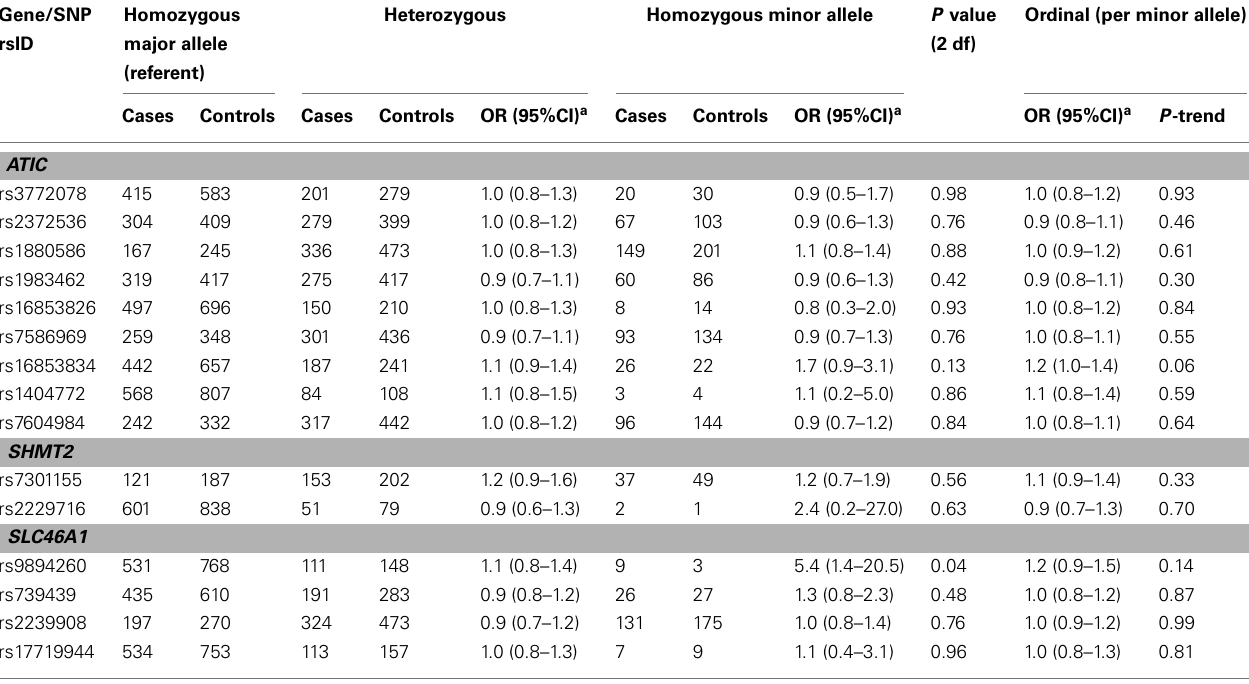
TableA4 | Odds ratios (OR) and 95% CIs for the main effect association between variants in ATIC , SHMT2 , and SLC46A1 and ovarian carcinoma among 1,575 Caucasian subjects (Phase 1), Mayo Clinic, and Duke